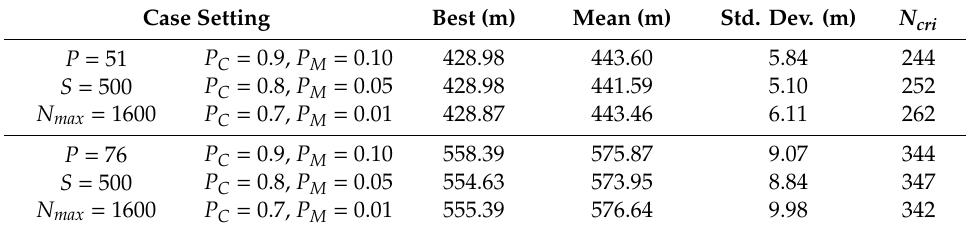
Table 2. Comparative results of various pairs of P C and P M for two numbers of planned points. Case Setting Best (m) Mean (m)